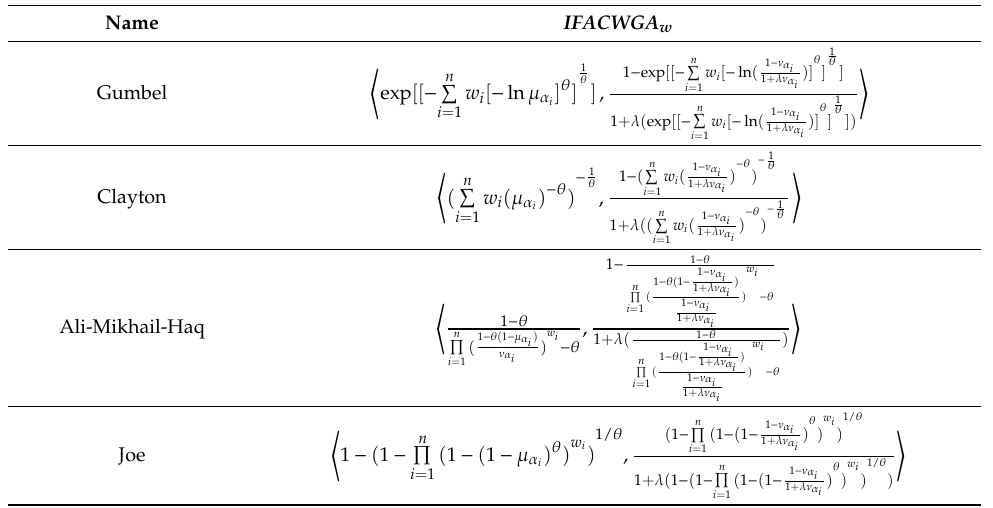
Table 5. Some Sugeno-Based Intuitionistic Fuzzy Archimedean Copula Weighted Geometric Aggregation